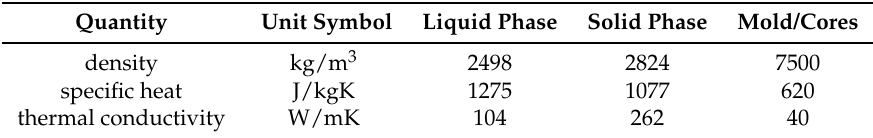
Table 2. Physical properties of cast and mold/core material using during computer simulation of Al–2%Cu alloy solidification.